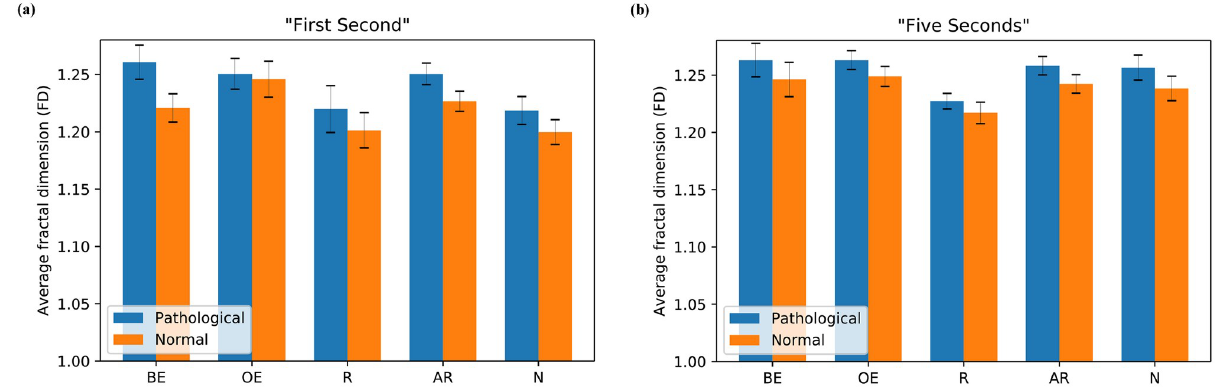
Fig 6. Average visual search complexity of scanpaths for pathological and normal stimuli across different groups of participants: Brain-experts (BE), Other-experts (OE), Registrars (R), All-radiologists (AR), and Na ï ves (N) (a) “First Second” and (b) “Five Seconds”.